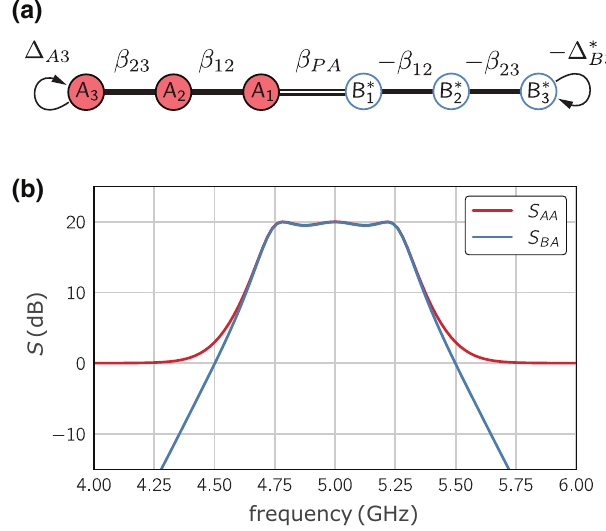
FIG. 20. (a) Coupled-mode graph for a matched nondegener- ate parametric amplifier, (b) S parameters for a matched paramet- ric amplifier. Here S AA is the signal reflection gain, and S BA is the signal-idler